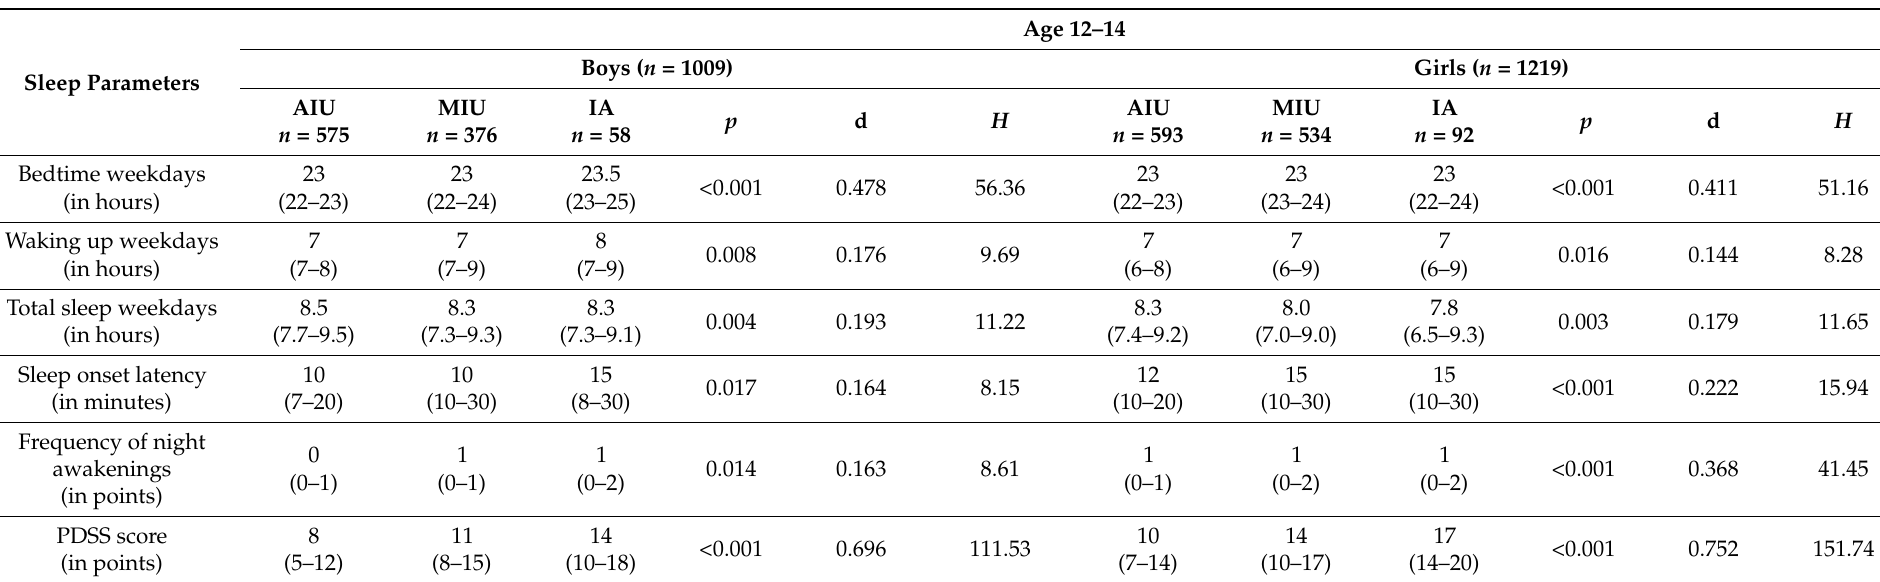
Table 3. Sleep parameters in adolescents aged 12–14 with IA verified with Chen Internet Addiction Scale